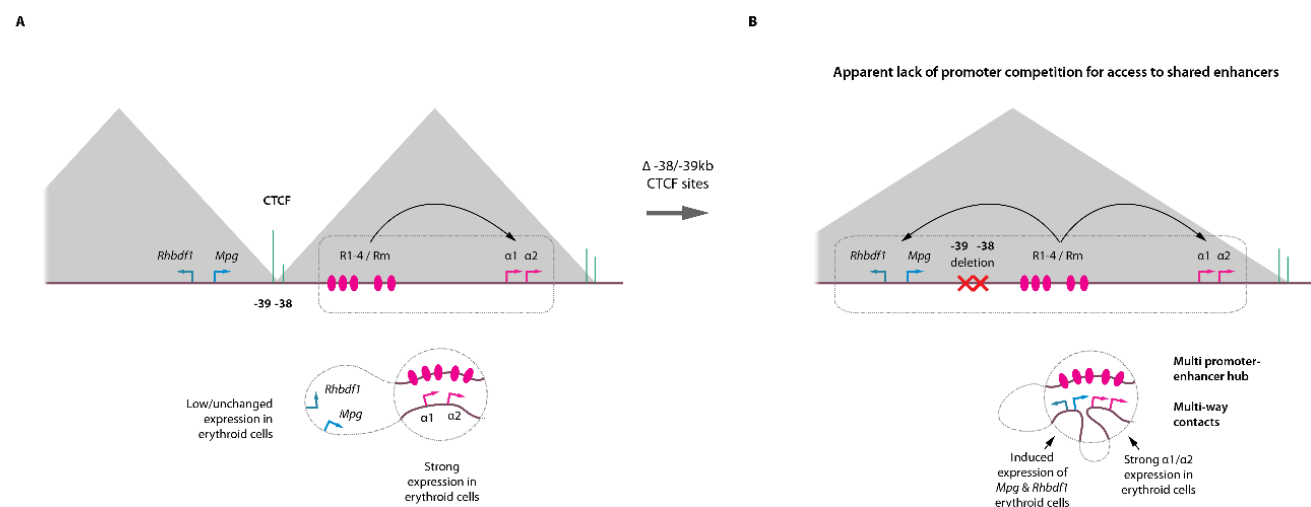
Figure 2. Enhancer–promoter hubs in erythroid cells. ( A ) Top, cartoon representation of the mouse α -globin locus with the corresponding (sub-)TADs (grey triangles), key CTCF binding sites (green) and α enhancers (R1-R4, Rm). Bottom, distal enhancer looping towards the α -globin promoters induce strong transcriptional activation. The − 38/ − 39 kb CTCF elements act as a barrier to loop extrusion preventing interactions with the Mpg and Rhbdf1 in the neighboring TAD. ( B ) Engineered locus with focused deletion of the CTCF − 38/ − 39 kb sites. The absence of these CTCF elements leads to concomitant activation of the Mpg and Rhbdf1 and α -globin genes by the R1-R4/Rm enhancers. The enhancer hub can accommodate several promoters in a single structure without evidence for promoter competition for access to shared